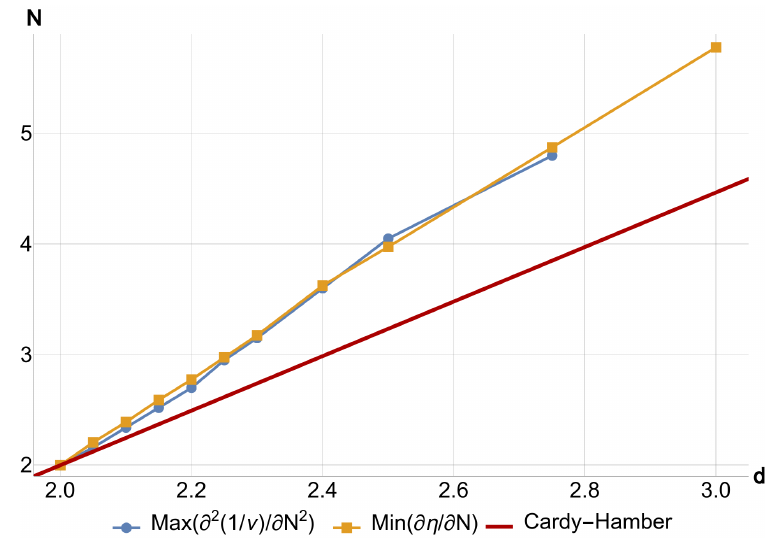
ν − 1 and the minima of ∂